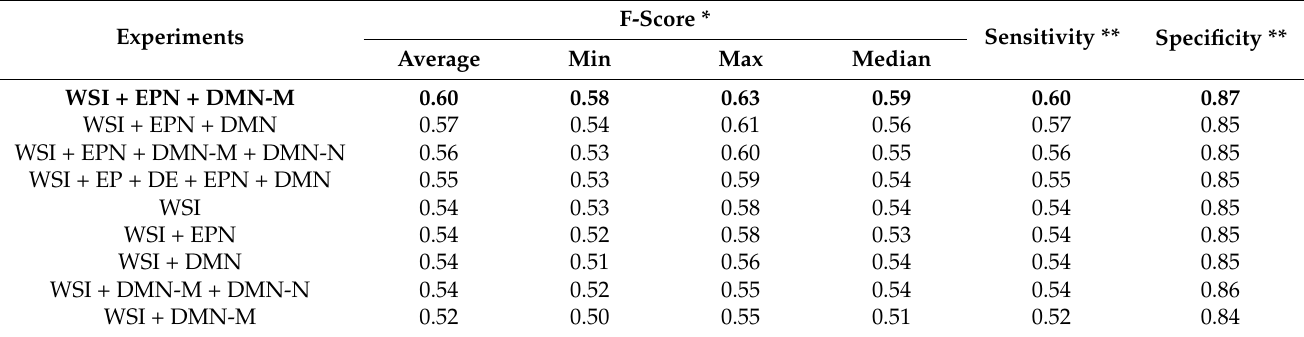
Table 3. Experimental results of WSI diagnosis along with segmentation masks.